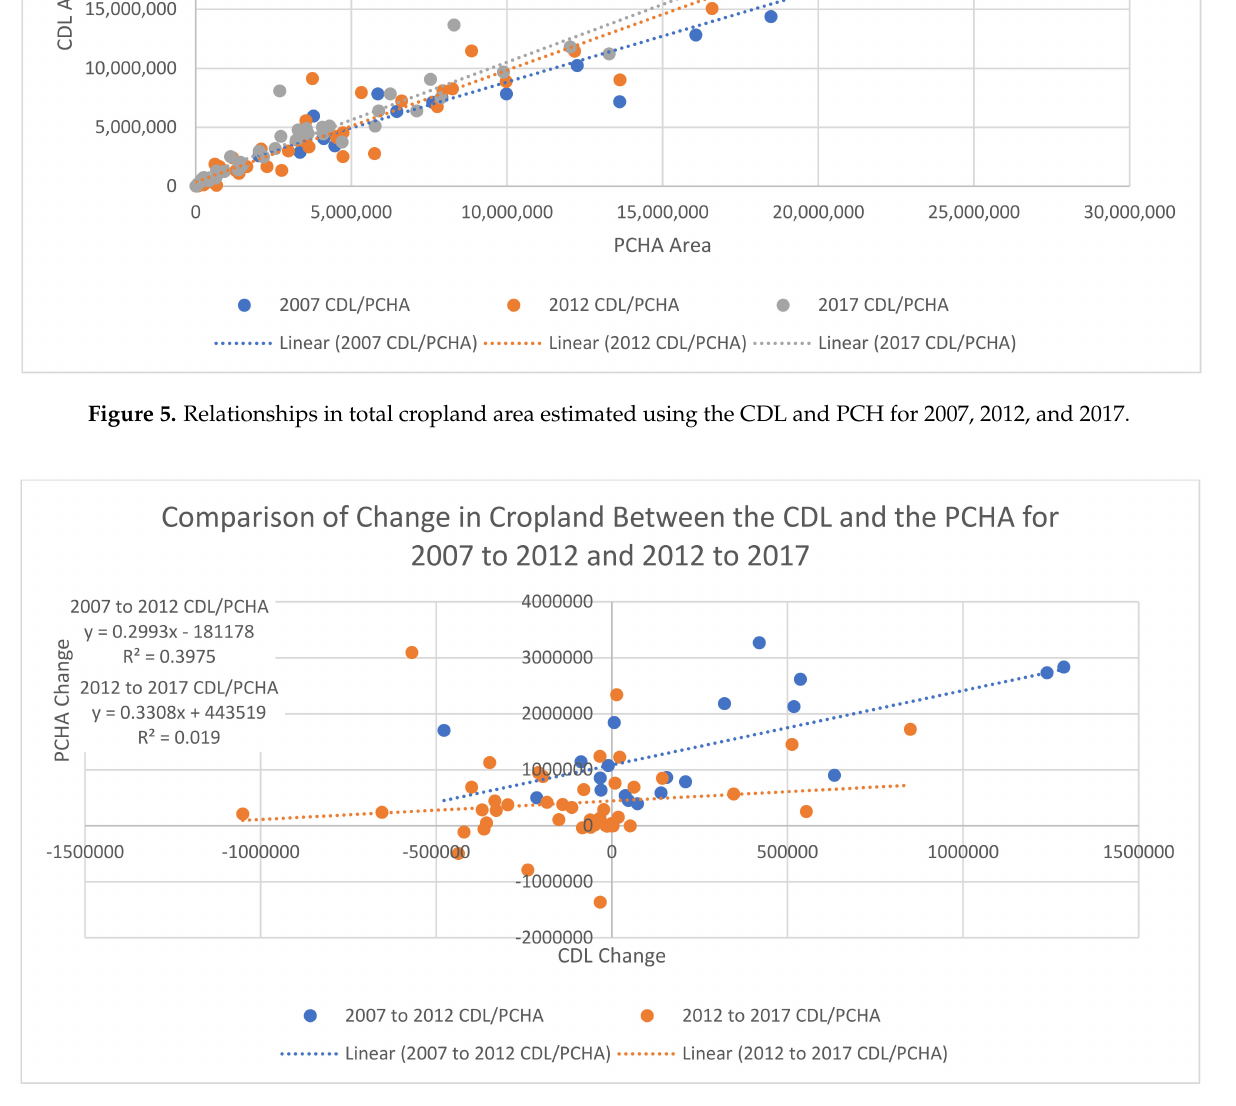
Figure 6. Relationships in total cropland change estimated using the CDL compared to the PCHA for the 2007 to 2012 and 2012 to